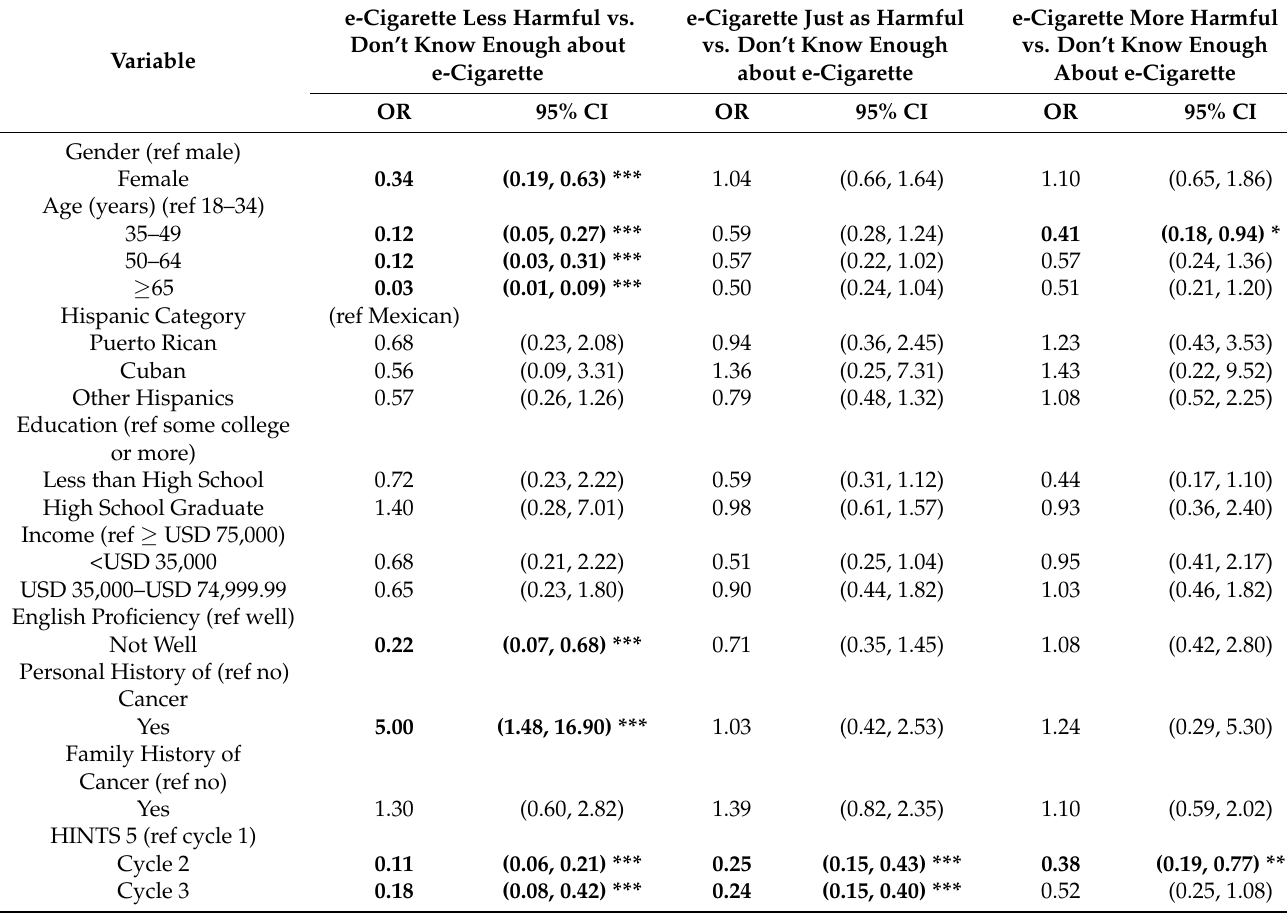
Table 4. Multivariable multinomial logistic regression model comparing perceptions around harm of e-cigarettes compared to cigarettes ( N =